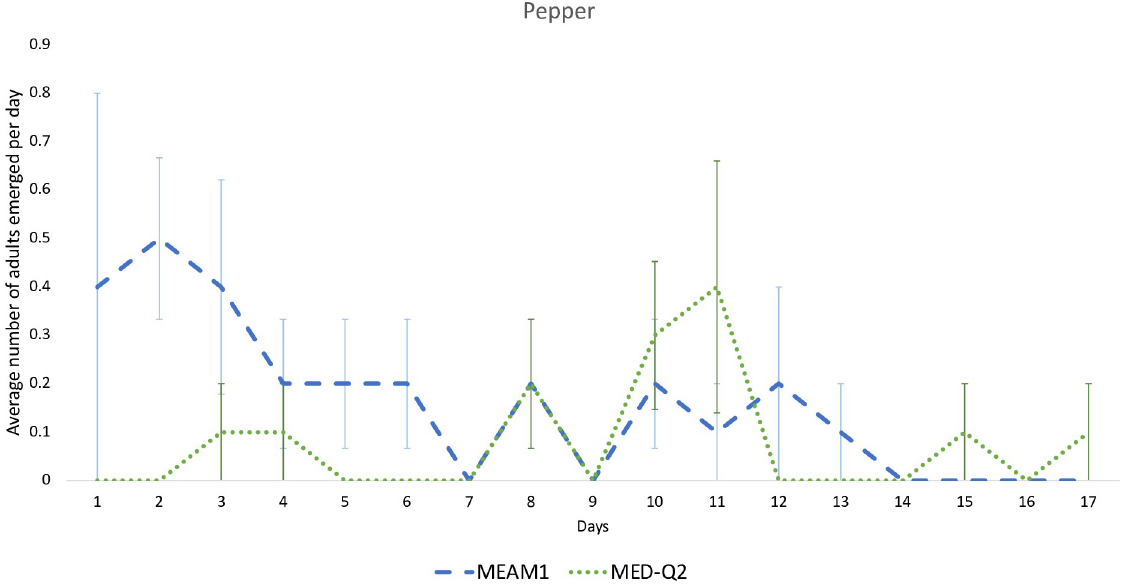
Fig 2. Number of adults emerged for MEAM1 and MED-Q2 per day on pepper since the first emergence